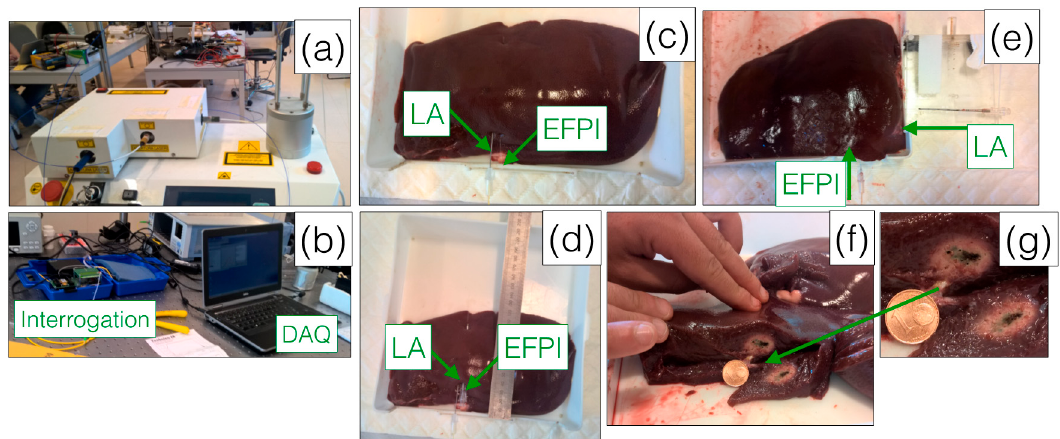
Figure 3. Picture of experimental setup and LA outcomes. ( a ) Medical-grade Nd:YAG laser, with 4 outputs; ( b ) EFPI interrogation box, and data acquisition (DAQ) via software; ( c – e ) Positioning of EFPI and LA inside the animal phantom, after insertion needle is removed ( c ), and prior to needle removal ( d ) with parallel positioning, and for perpendicular positioning ( e ); ( f ) Outcome of LA experiment, referenced to a 1 € cent coin (16.25 mm diameter); ( g ) Zoom of ablated tissue.